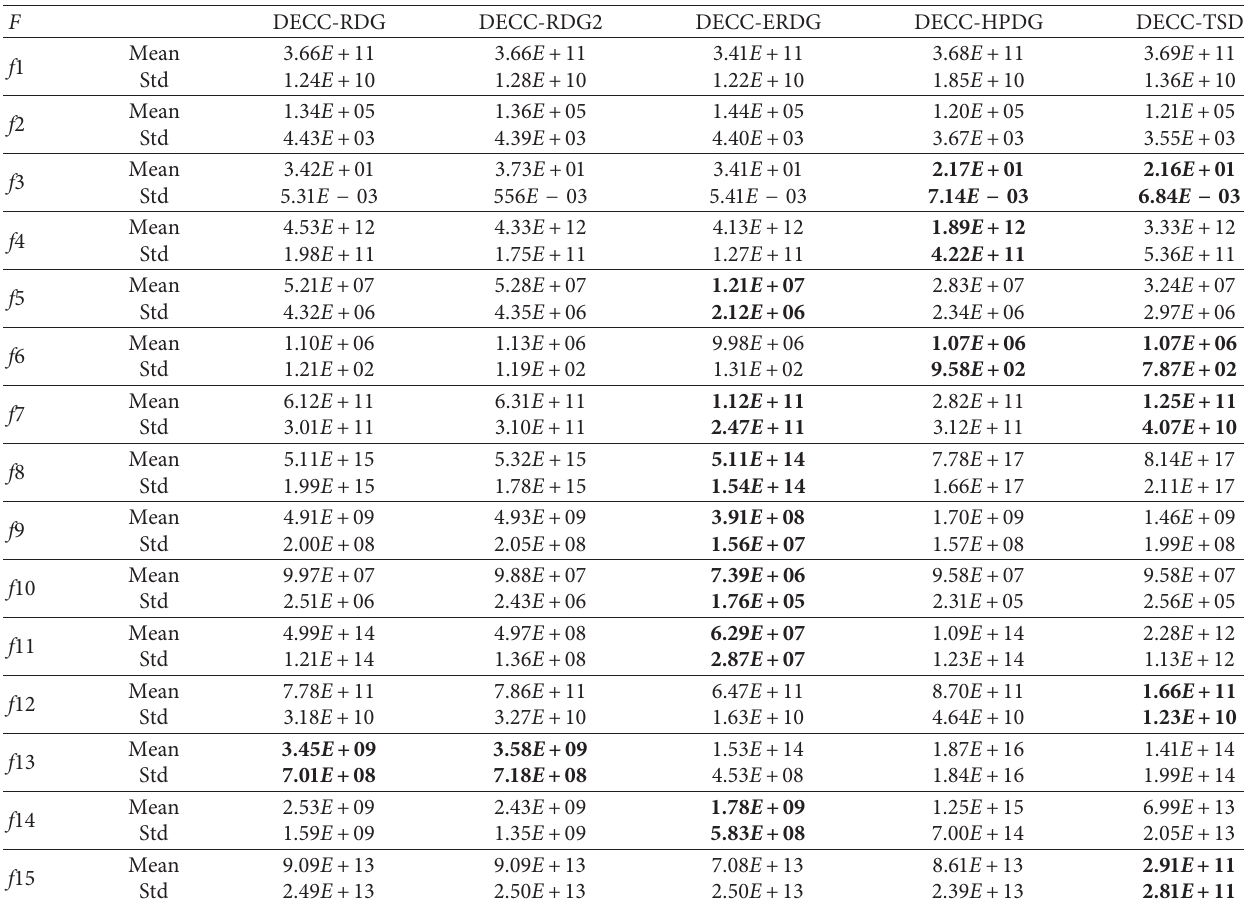
Table 11: The optimization results on CEC’2013 special sessions on large-scale global optimization, D � 1000. Average fitness values and deviations on CEC’2013 special sessions on large-scale global optimization over 25 independent results. The significantly best results are in bold (Wilcoxon test with home p value correction, α �